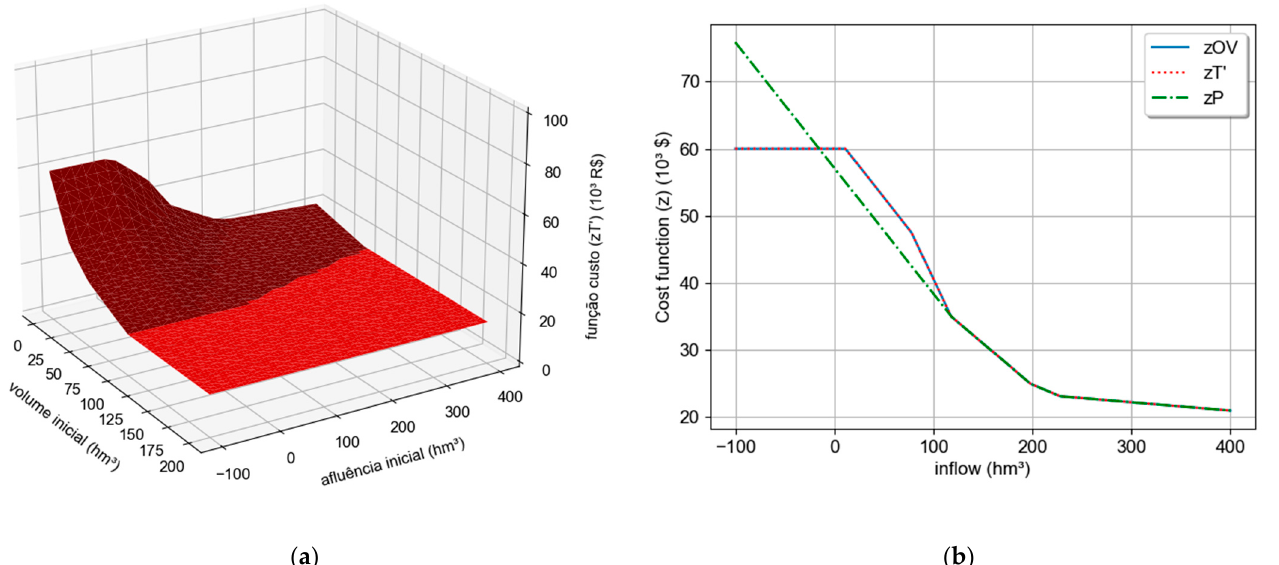
Figure 6. ( a ) Cost function (zT’) (10 3 $) per inflow(hm 3 ) by the truncation approach. ( b ) Comparison between the cost function (z) (10 3 $) by the optimal value approach (solid blue), truncation approach (dotted red), and penalty approach (dash and dot green).